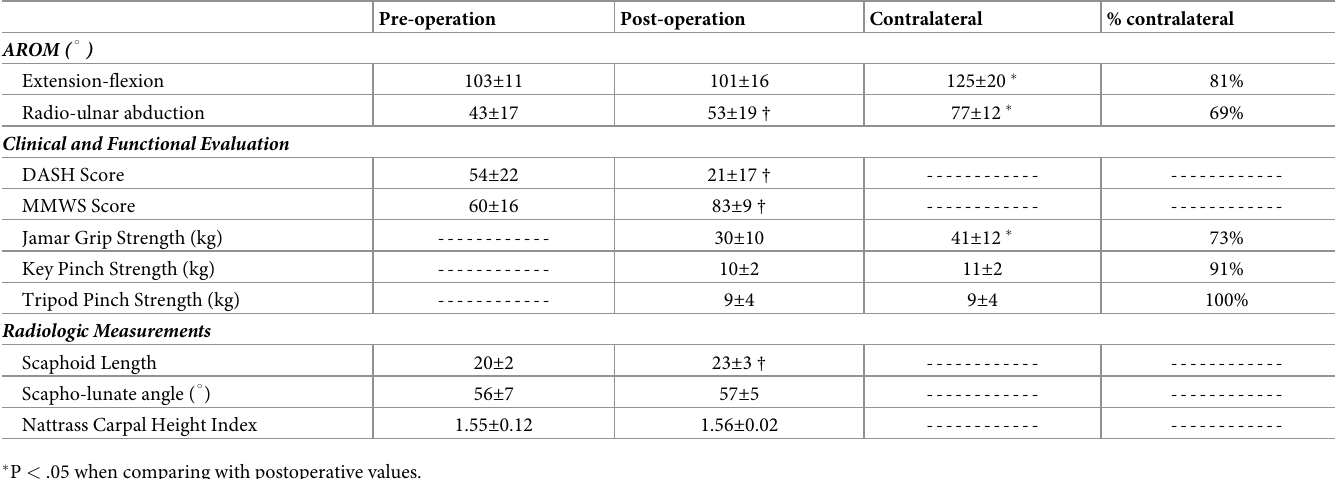
Table 3. Analysis of preoperative and postoperative outcomes of patients who achieved scaphoid